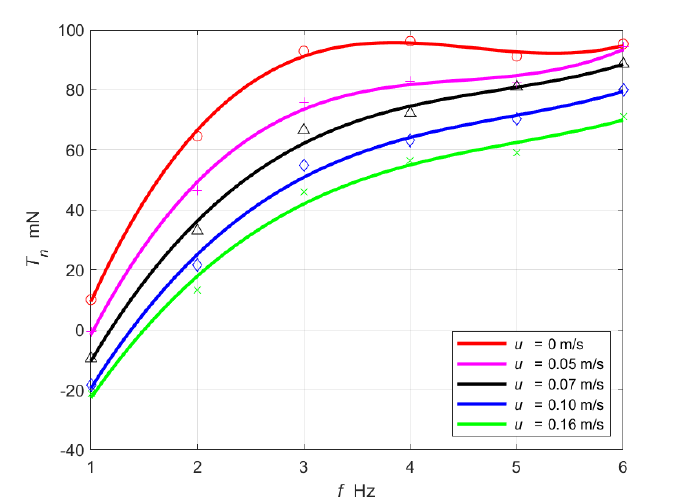
Figure 8. The mean value of the net thrust for a flexible fin made from a thin steel sheet.